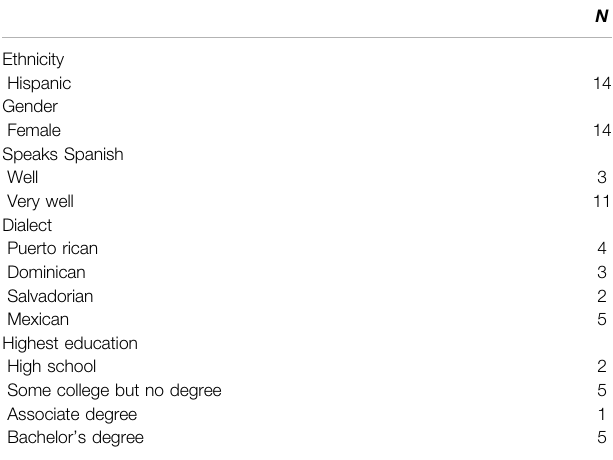
TABLE 3 | Focus Group Participants ’ Demographic